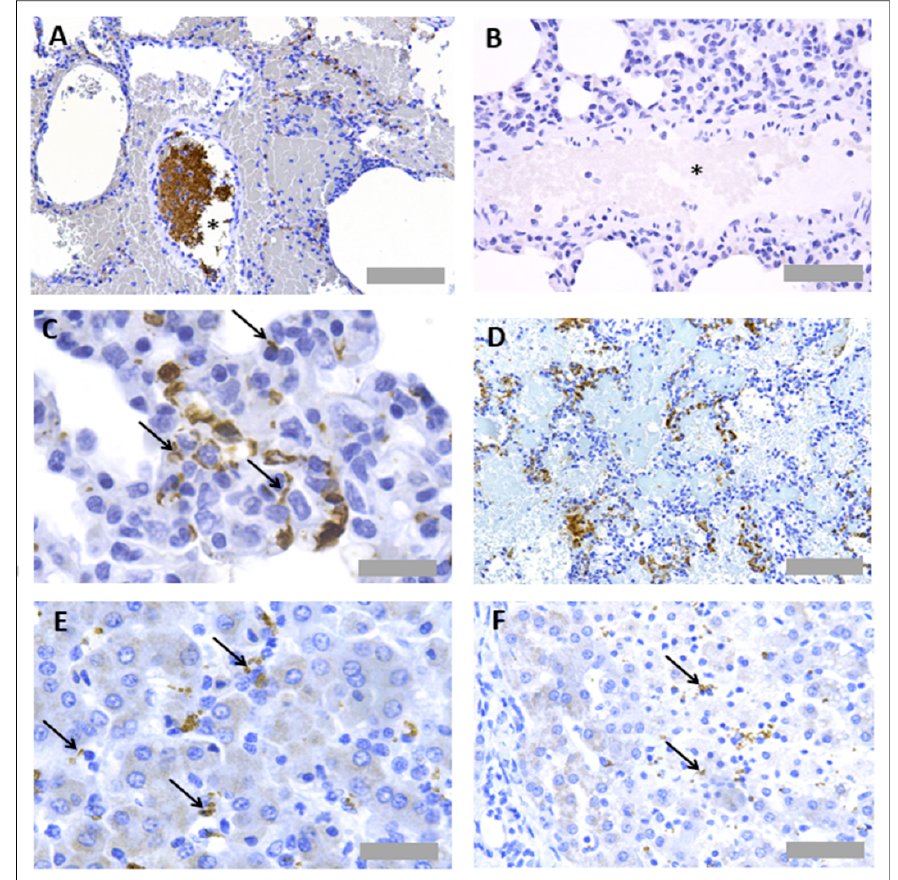
Figure 7. Platelet immunohistochemistry in FFPE pig lung and liver tissues . Sections were im- munostained with primary antibody ( A ) and without primary antibody ( B ), to ensure no unspecific binding of detection reagents. Representative images of neutrophil immunohistochemistry (anti- CD42b) in FFPE pig lung tissue ( C , D ) and FFPE pig liver tissue ( E , F ) are also shown. Asterisks denote blood vessels. Arrows denote CD42b+ platelet events. Scale bar = 100 μ m in Figures ( A , D ) (×20 objective), 50 μ m in Figure ( B , F ) and 30 μ m in Figures ( C , E ) (×63 objective).